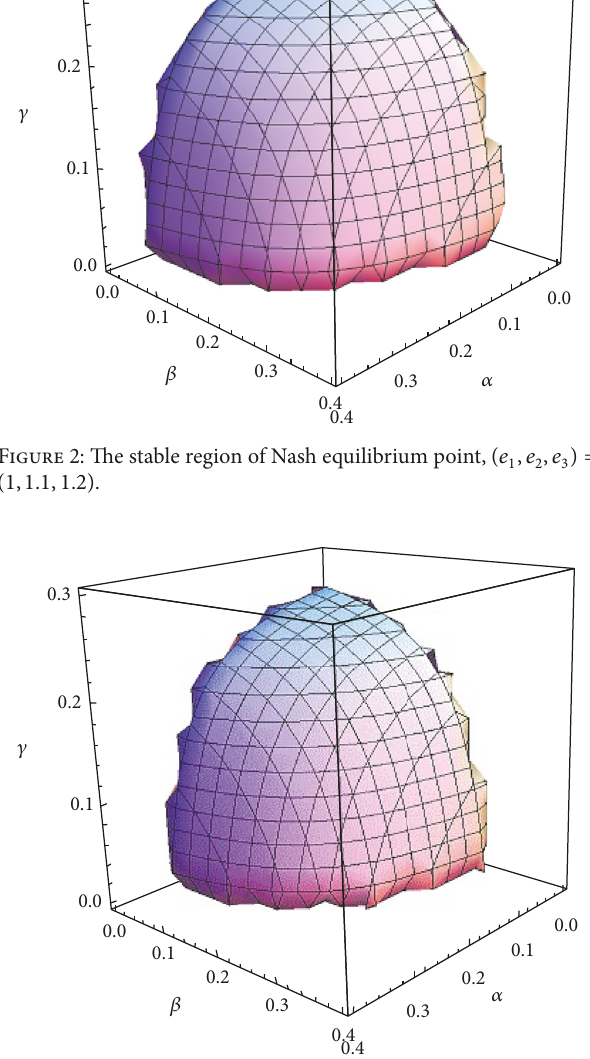
Figure 3: The stable region of Nash equilibrium point, (𝑒 1 ,𝑒 2 ,𝑒 3 ) = (0.8, 0.9, 1) .